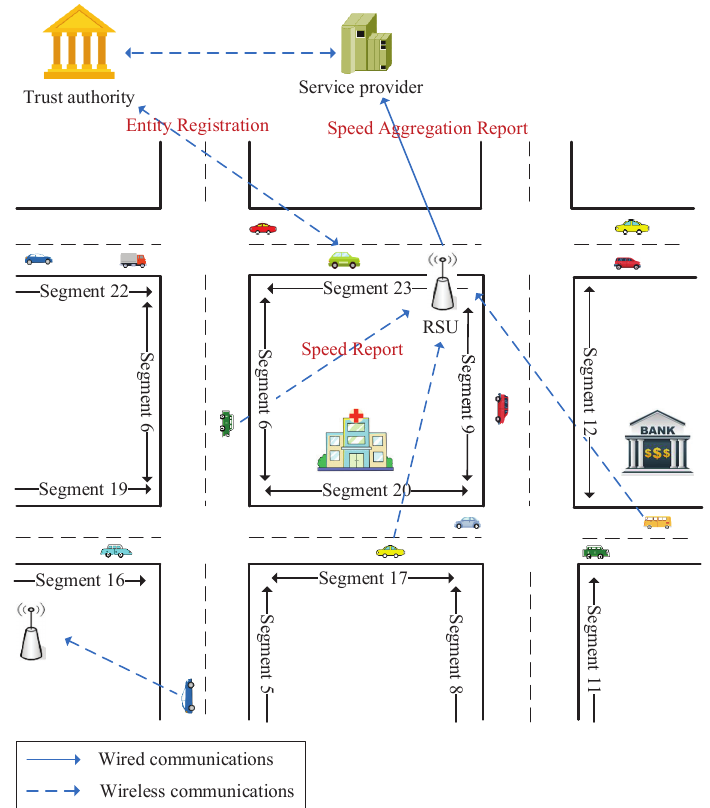
Figure 2. Using trust values to link pseudonyms in a given time